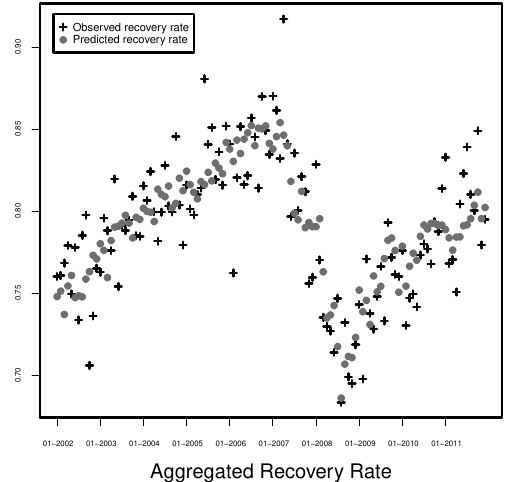
Figure 10. Observed and predicted aggregated recovery